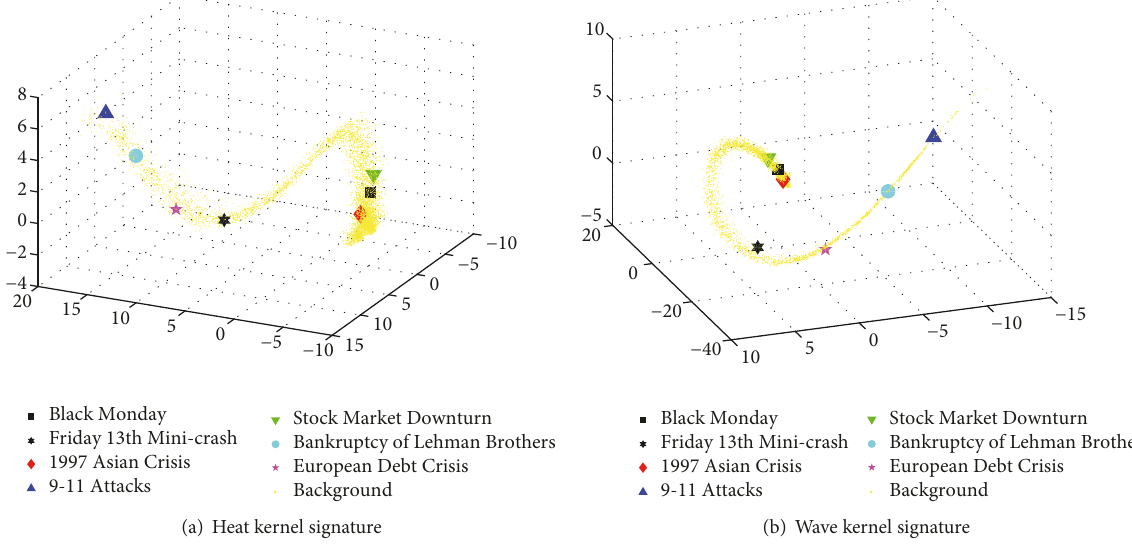
Figure 6: The 3D visualisation of PCA plots in the dynamic stock correlation networks described by other thermodynamic characterisation methods. (a) Heat kernel signature; (b) wave kernel